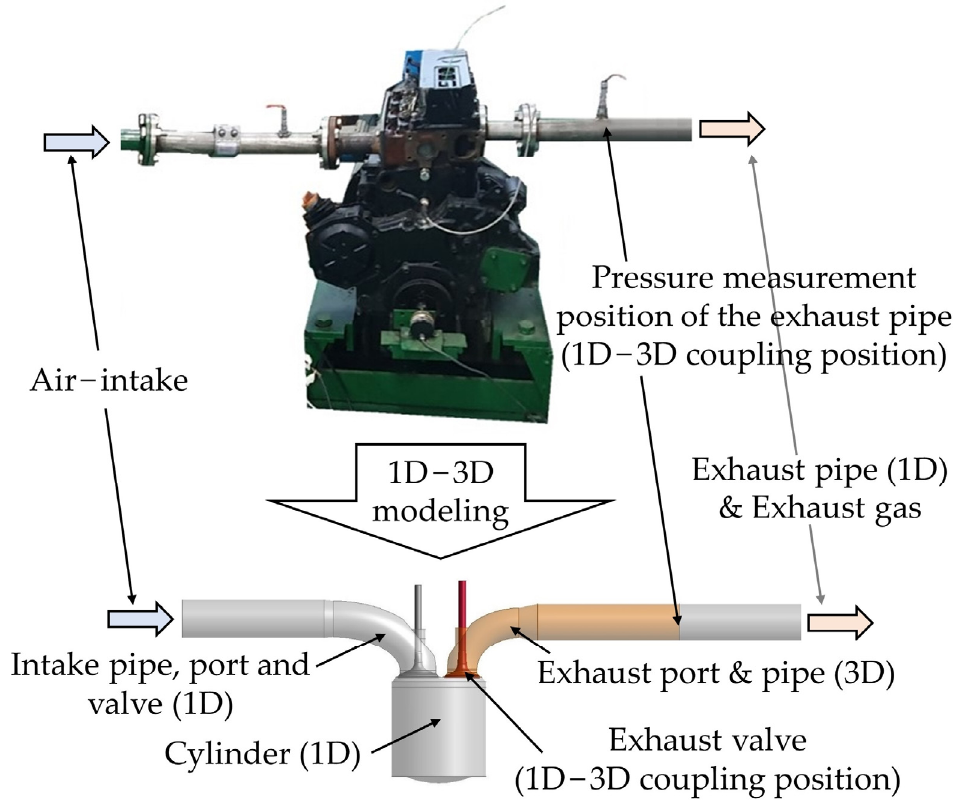
Figure 1. Schematic diagram of modeling the experimental apparatus. Table 1. Specifications of the experimental